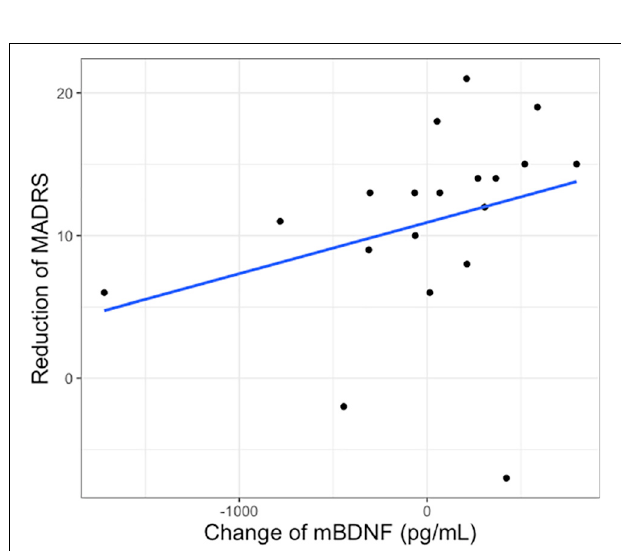
FIGURE 2 | Change of plasma mBDNF after first intervention and reduction of Montgomery–Åsberg Depression Rating Scale score after 2 weeks of treatment (MADRS1 to 3) in the ketamine